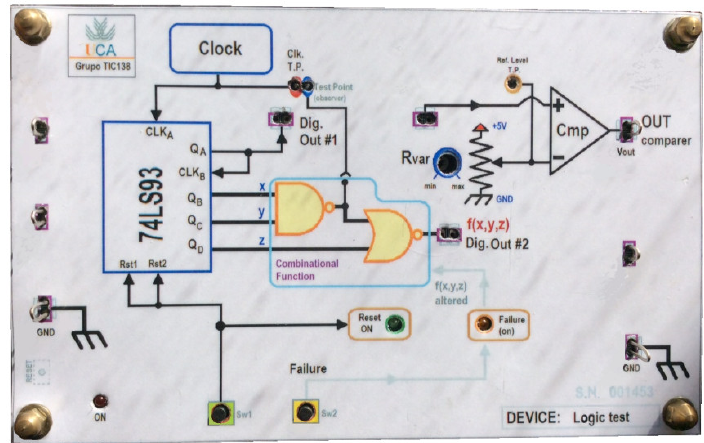
Figure 9. Graphical-cover for the digital emulation example.